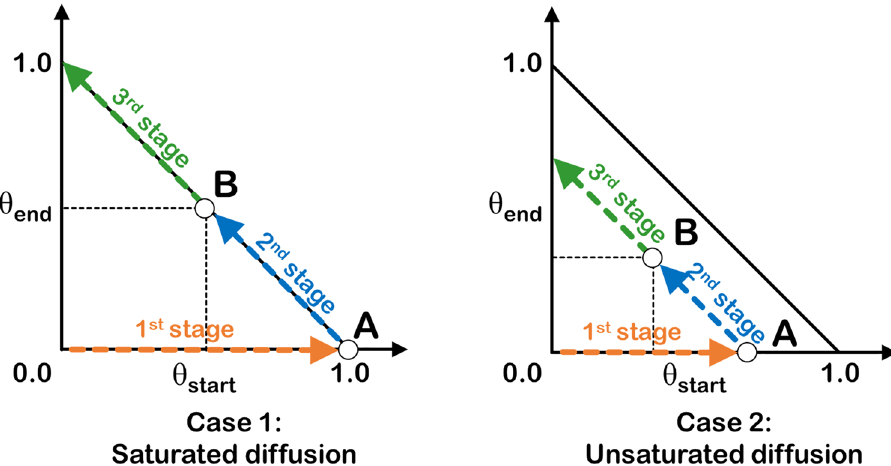
Figure 12. Coke mobility scheme (CMS) illustrated by the surface coverage of C at the initial and terminal diffusion sites, where two cases: (1) saturated diffusion and (2) unsaturated diffusion, were proposed for surface C diffusion in all system. (The 45-degree solid line marked the limit for the maximum total surface coverage of C of such two sites that is equal to unity).